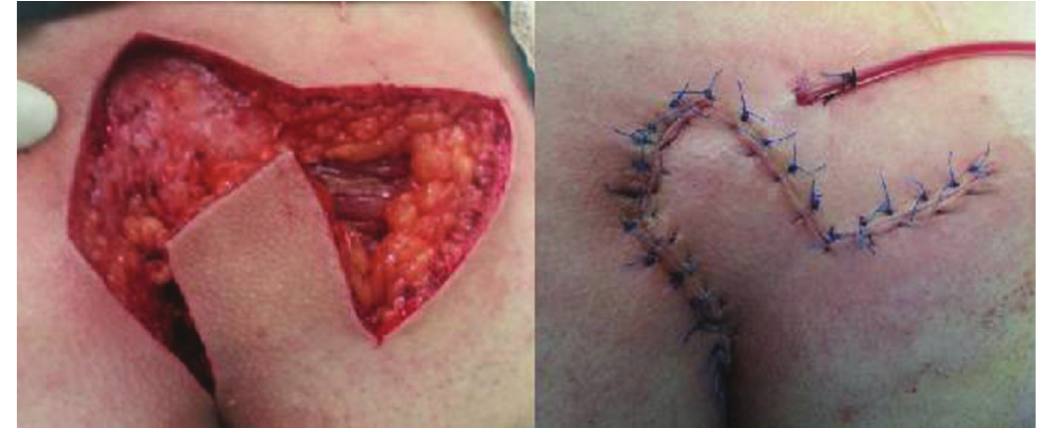
Figure 2 - Limberg flap technique.